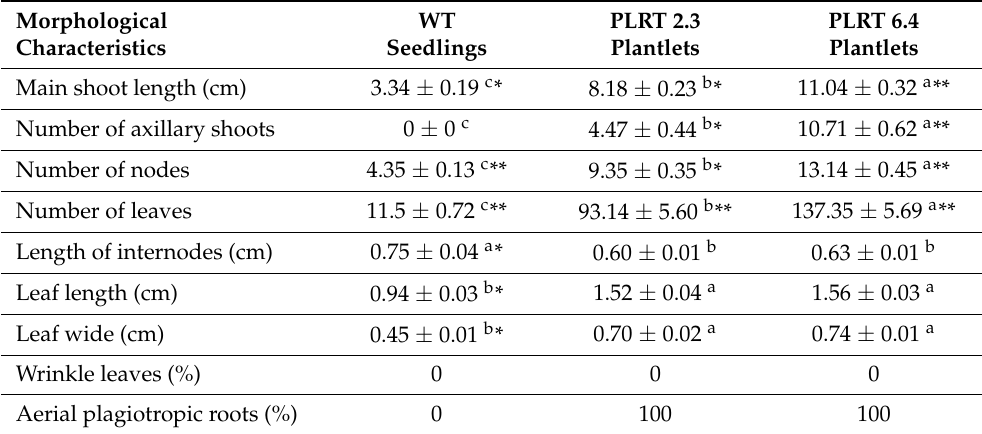
Figure 5. Morphologic characteristics of WT seedlings and regenerated plantlets derived from the transformed hairy root lines of L. racemosa . ( A ) WT seedling; ( B ) plantlet derived from the line LRT 2.3; ( C ) plantlet derived from the line LRT 6.4. Table 2. Data from the ANOVA analysis of the morphological characteristics of the plantlets regener- ated from the hairy root lines as compared with WT seedlings after 30 days on